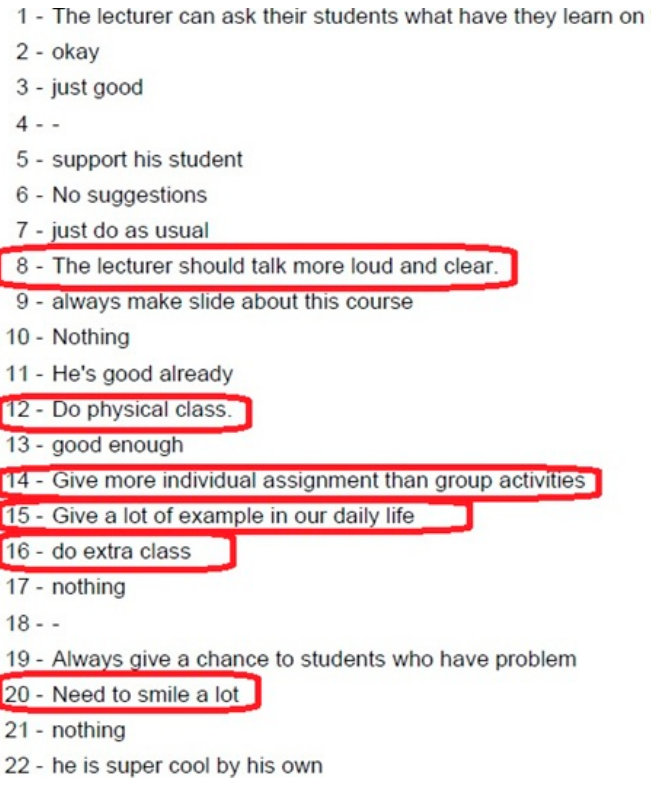
Figure 2. Screenshot (2) of highlighted students’ comments.